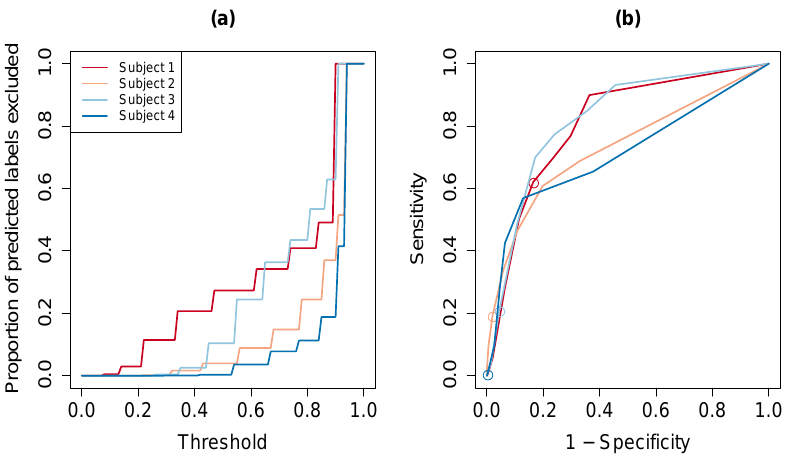
Figure 7. Prediction exclusions based on logistic regression model. Panel ( a ) shows the proportion of predicted labels excluded ( y -axis) as a function of threshold choice ( x -axis), separately for each participant. Panel ( b ) shows the participant-specific ROC curves. In each curve, we circle the point corresponding to the threshold of 0.5 as a